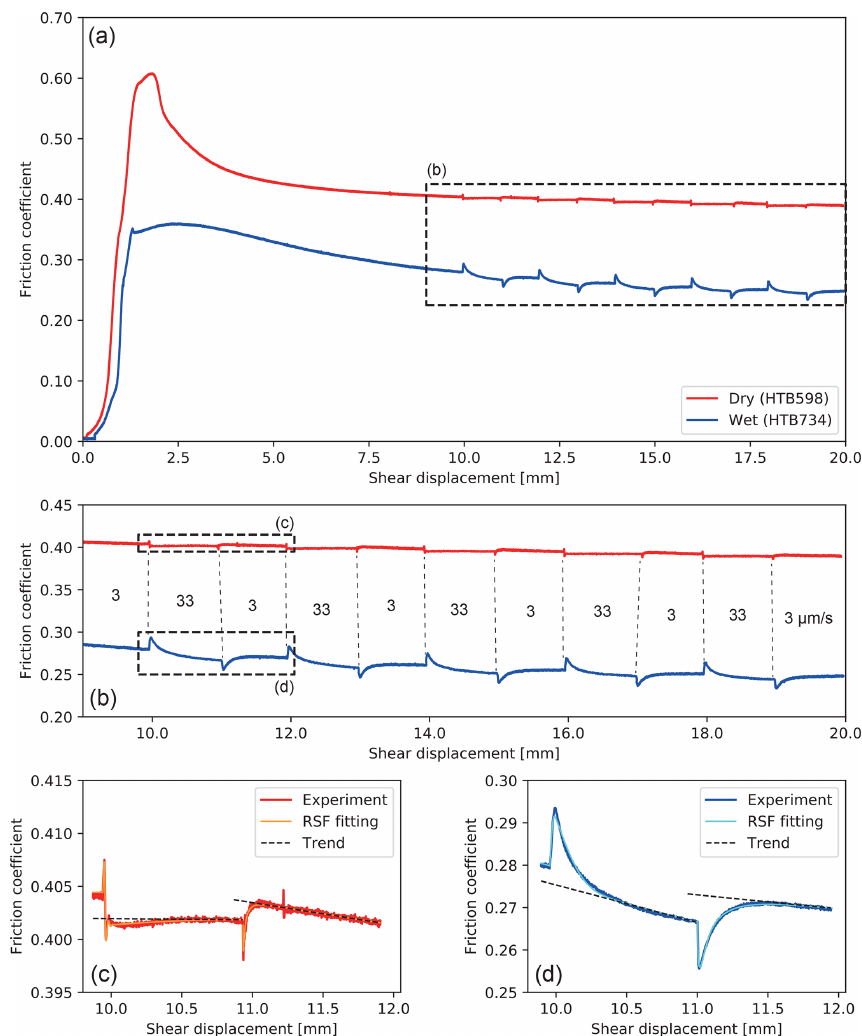
Figure 2. (a) Friction coefficients for dry (HTB598) and wet (HTB734) experiments at a normal stress of 20MPa. Slip-weakening behavior was observed after the peak under both dry and wet conditions. (b) Enhanced view of velocity step sequences as indicated by the dotted square in (a) . The velocities at given shear displacements are displayed between two lines. (c,d) Enhanced views of velocity steps in the squares in (b) . Second variables were introduced for upsteps of HTB598 (c)